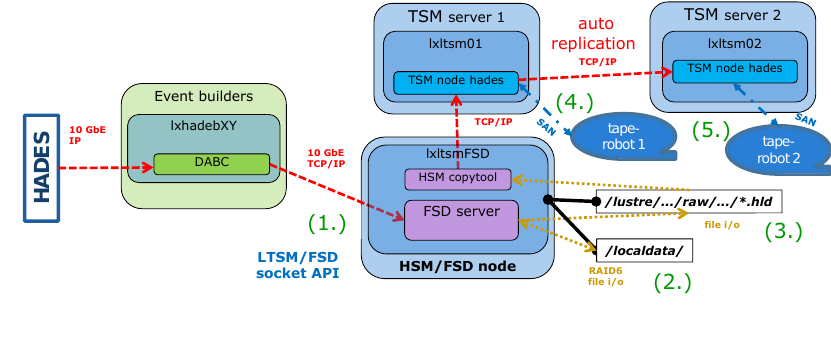
Figure 6. Event building storage with the future file system daemon (FSD). See main text for